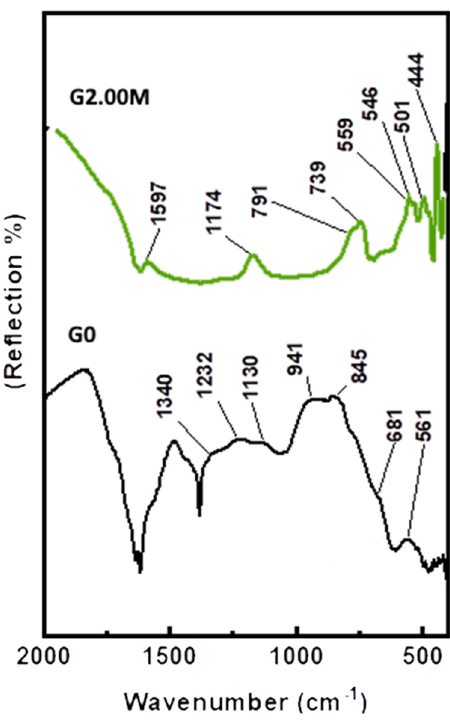
Figure 10: FTIR re fl ection spectra of G0 and G2.00M glass discs sintered 1,100°C/2 h and soaked in SBF for a month.